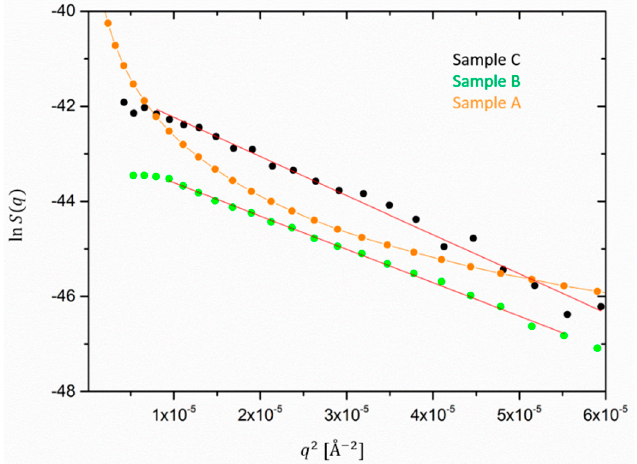
Figure 7. Guinier extrapolation for the silica cluster radius for sample C (black). The fit cannot be uniquely applied to sample B (green) due to the strong deviation from linearity.